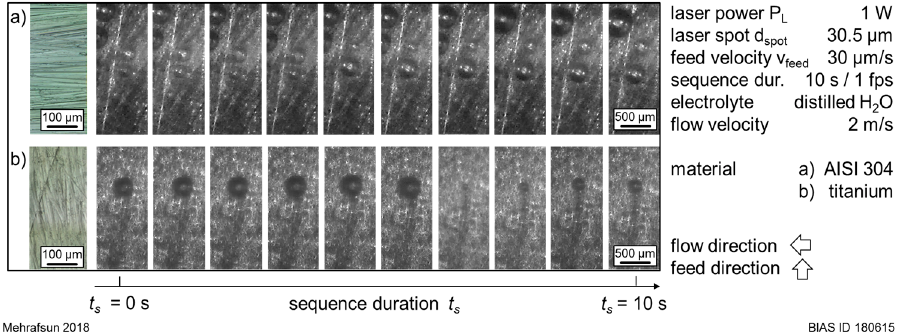
Figure 14. CCD snapshots of the laser irradiation of ( a ) stainless steel and ( b ) titanium in distilled water at a laser power of 1 W and a feed velocity of 30 μ m/s (gas bubble formation was observed).